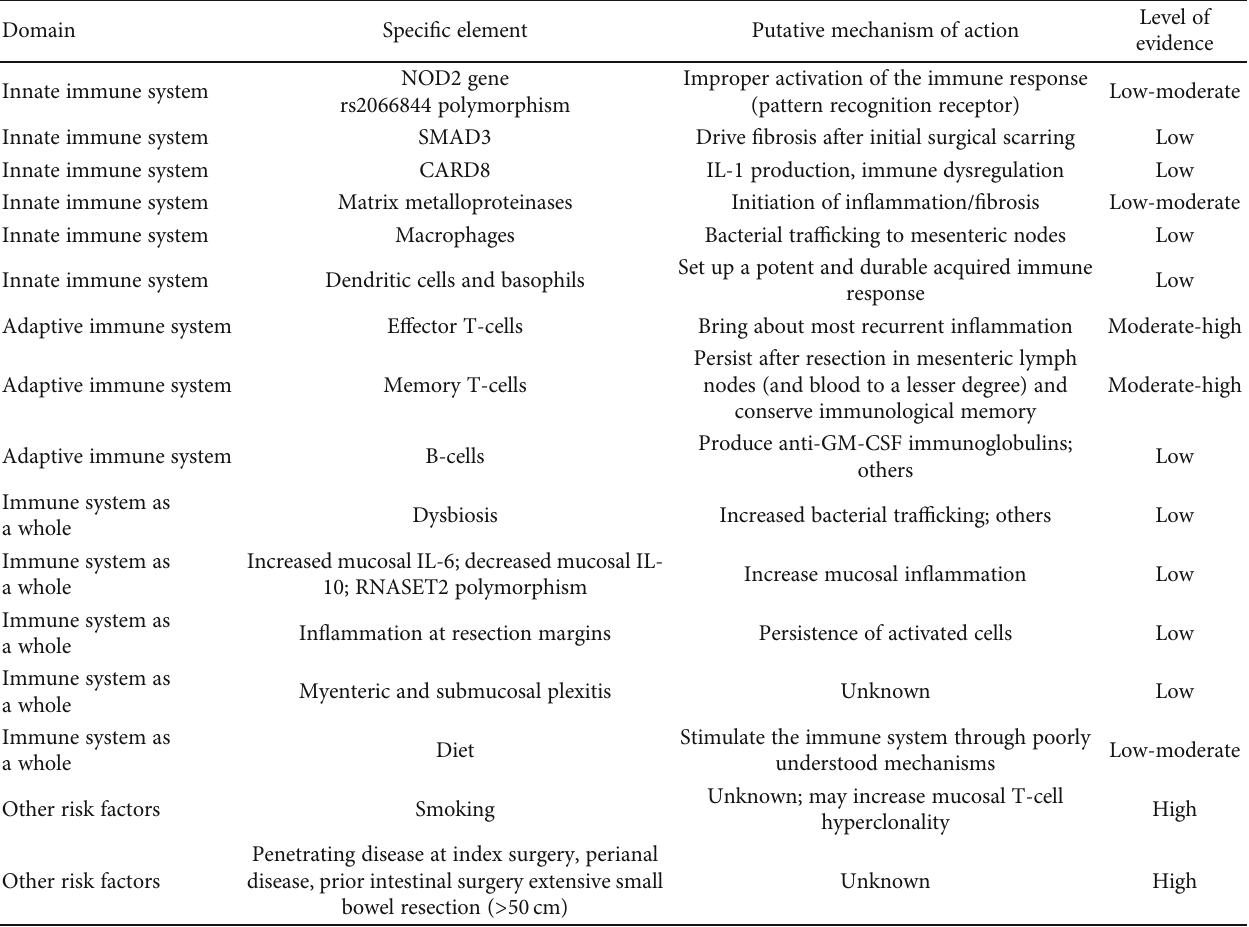
Table 1: Elements involved in CD